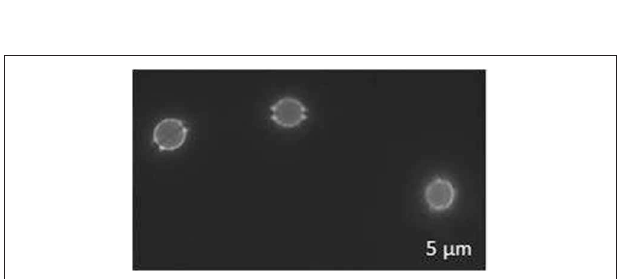
FIGURE 6 | Ascospores of A. fumigatus labeled by Eosin